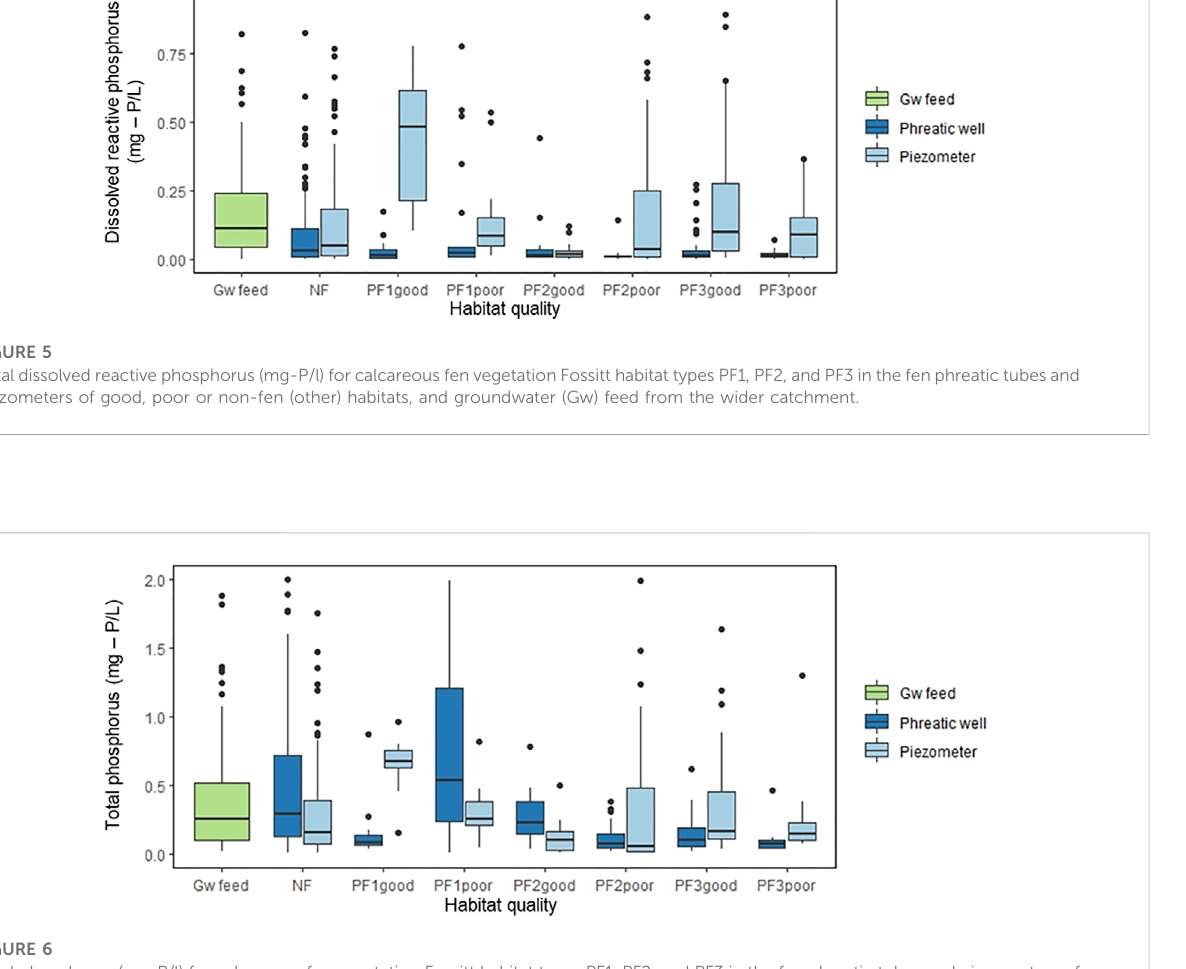
Frontiers in Earth